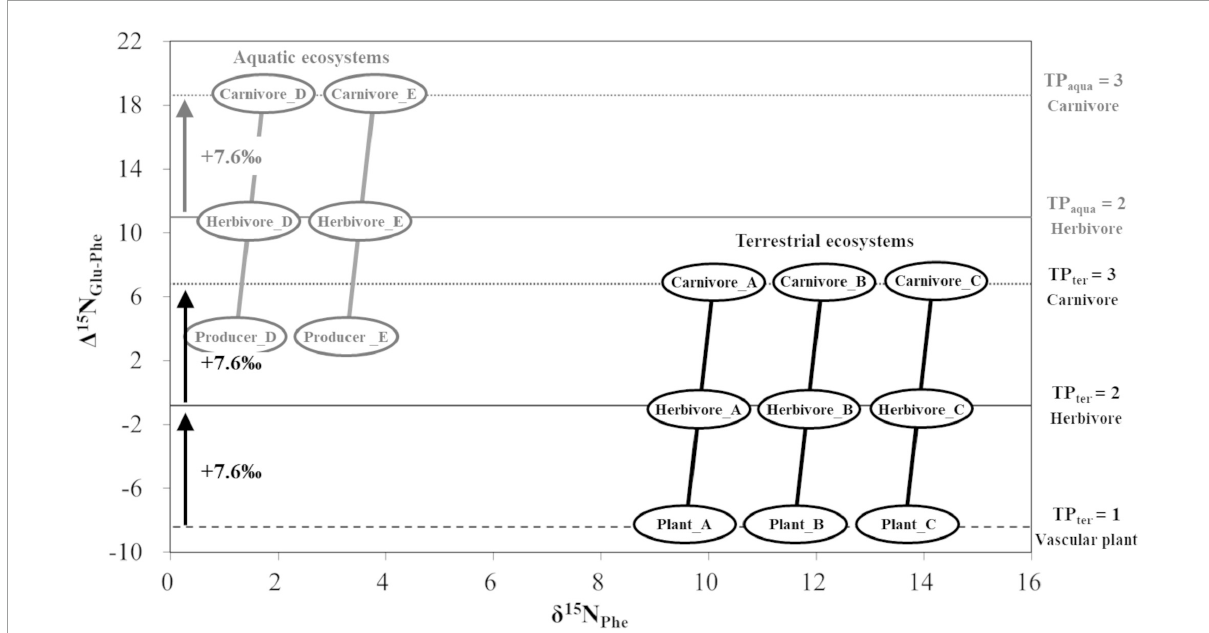
FIGURE1 δ 15 N (cid:49) 15 N Phe and estimated trophic positions based on Glu − Phe for organism in terrestrial (TP ter ) and aquatic ecosystem (TP aqua ) according to Chikaraishi et al. (2010) and Itahashi et al. (2020). TPs of aquatic ecosystems are calculated differently to those of terrestrial ecosystems based on difference of the (cid:49) 15 N Glu − Phe between primary producers in aquatic ecosystems and in terrestrial